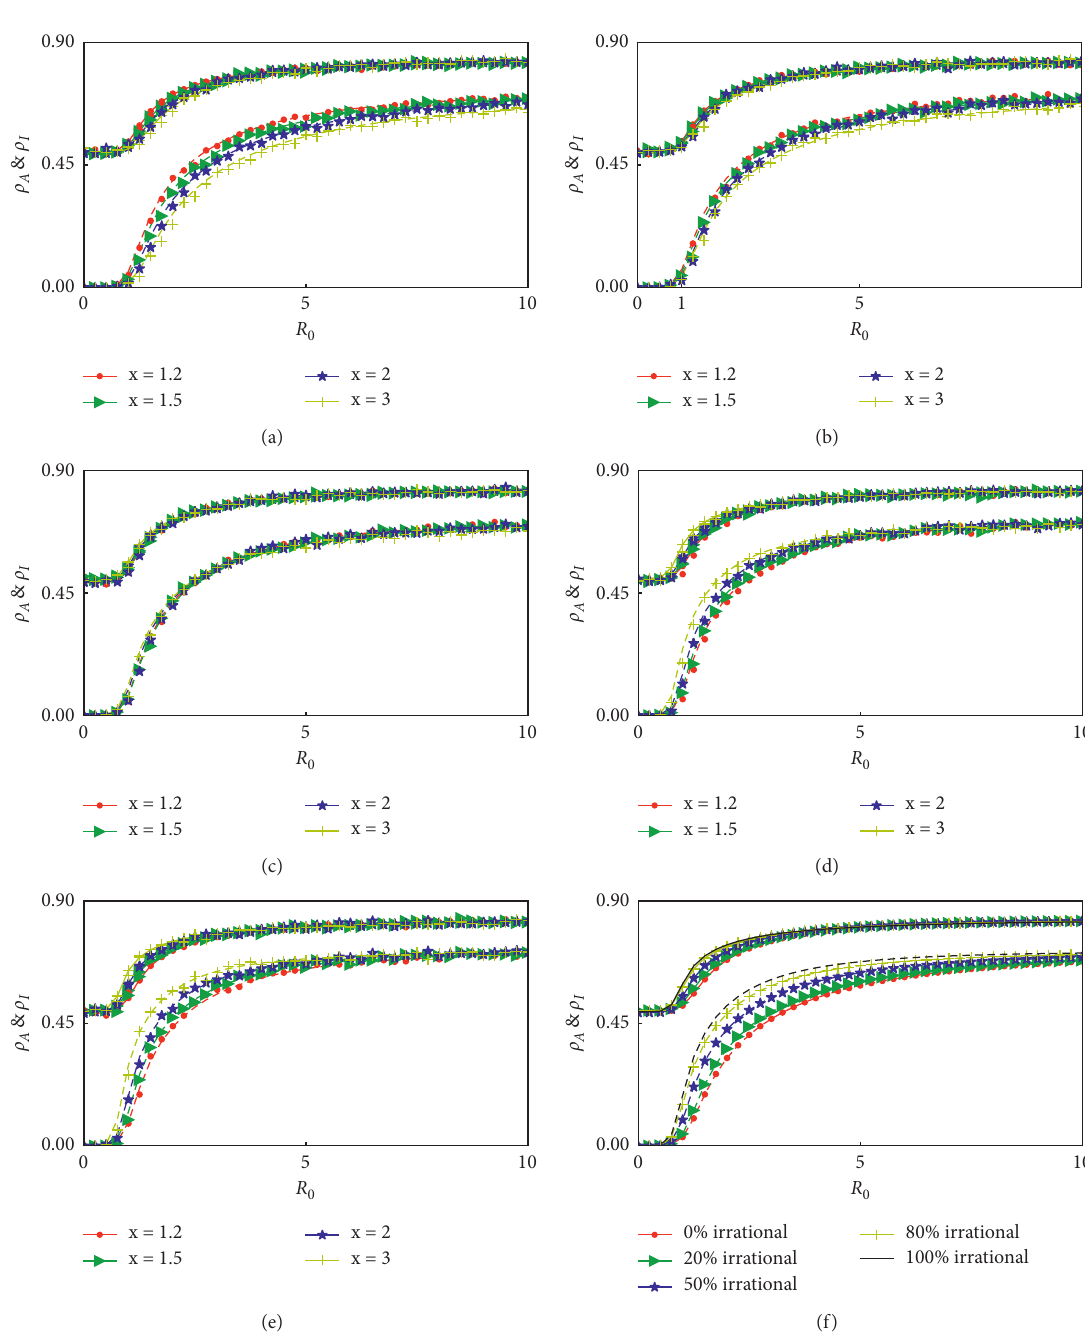
Figure 7: For the second form of dependence, where c � x − ρ A for rational individuals and c � x ρ A for irrational individuals, the dependence is calculated for (a) 0%, (b) 20%, (c) 50%, (d) 80%, and (e) 100% irrational of prevalence ρ A and prevalence ρ I on the infection rate R 0 individuals, respectively. Solid lines represent the ratio of awareness nodes ρ A and dashed lines represent the ratio of infected nodes. Symbols represent the simulation results and different colors correspond to different x values. (f) Comparison between cases of different ratios of irrational individuals, with x � 2. All calculations are based on δ � 0 . 6 and μ � 0 .